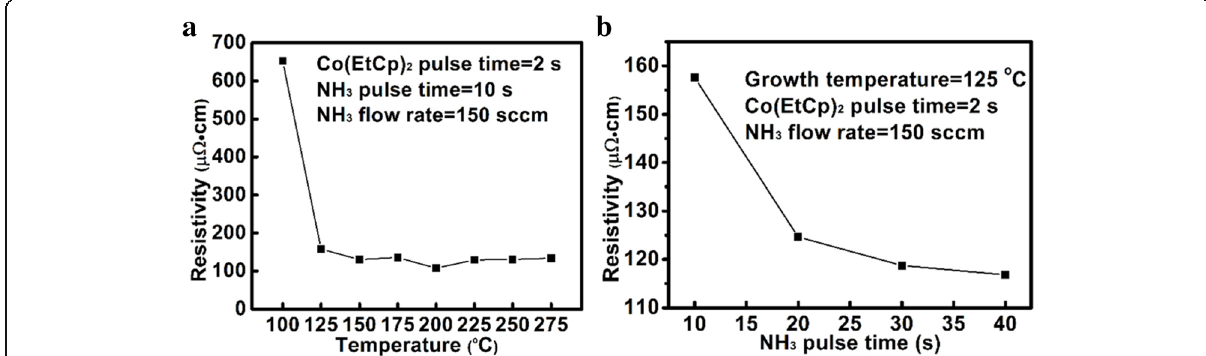
Fig. 6 The resistivity of the Co film as a function of growth temperature ( a ) and NH 3 pulse time ( b ),